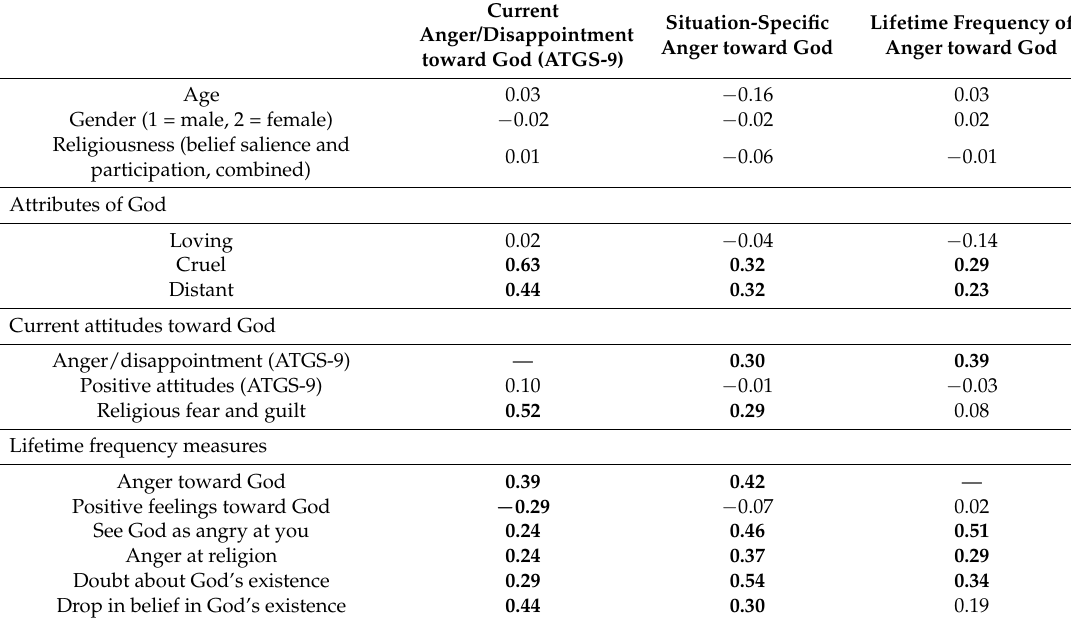
Table 2. Indian sample: Correlations between key study variables and three measures of anger toward